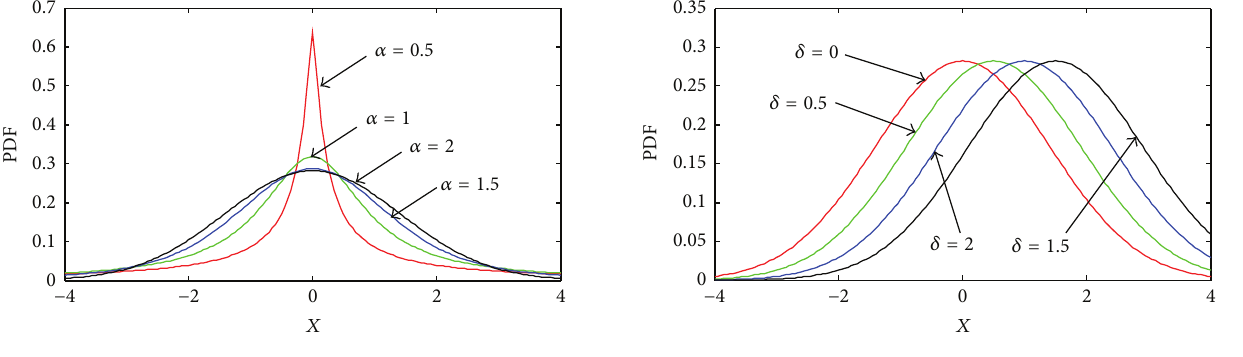
Figure 1: PDF of stable distribution with different 𝛼 values (𝛽 = 0, 𝛾 = 1, 𝛿 = 0) .